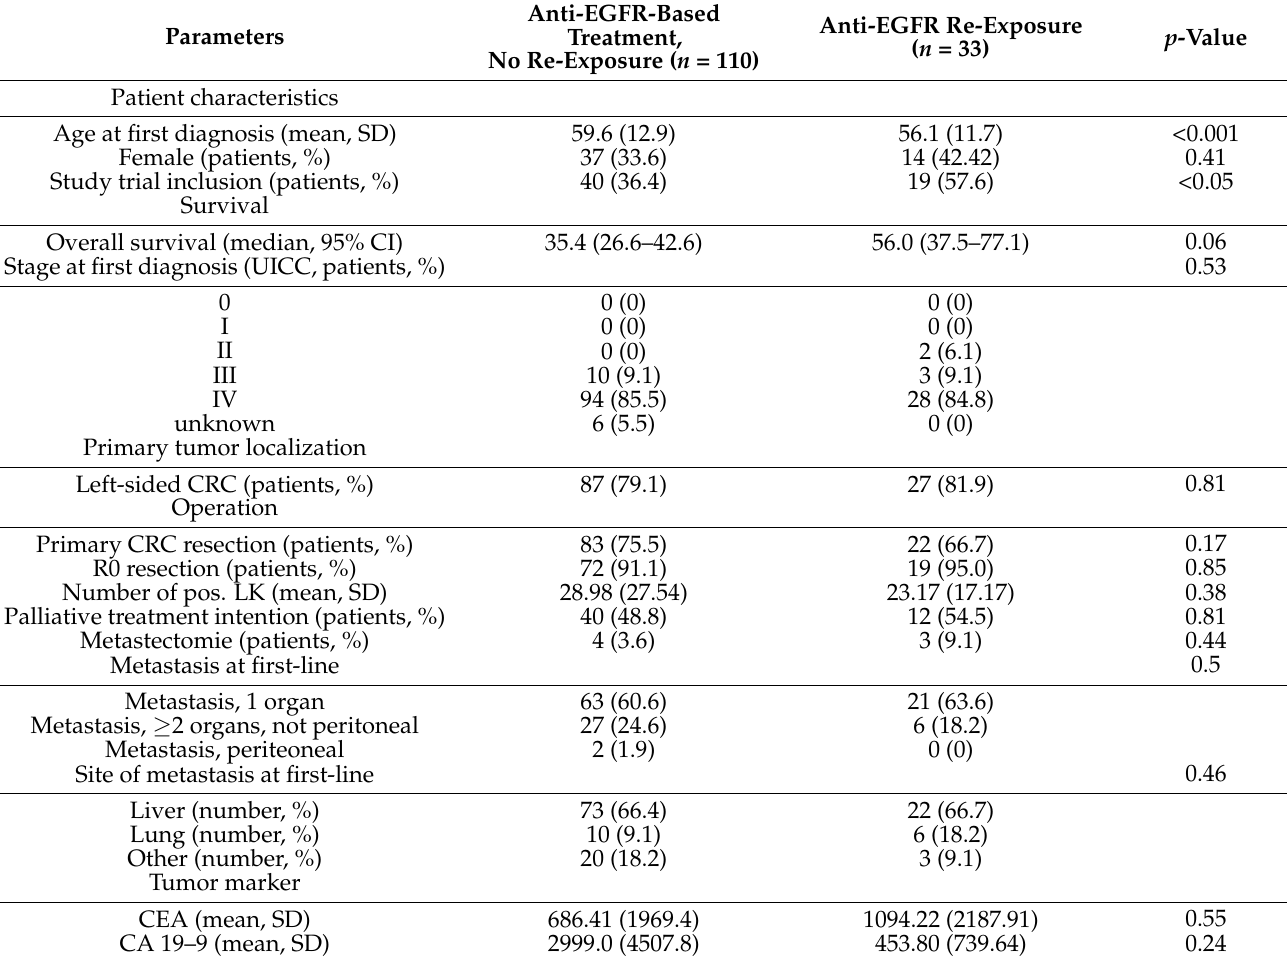
Table 2. Characteristics of patients receiving anti-EGFR treatment.